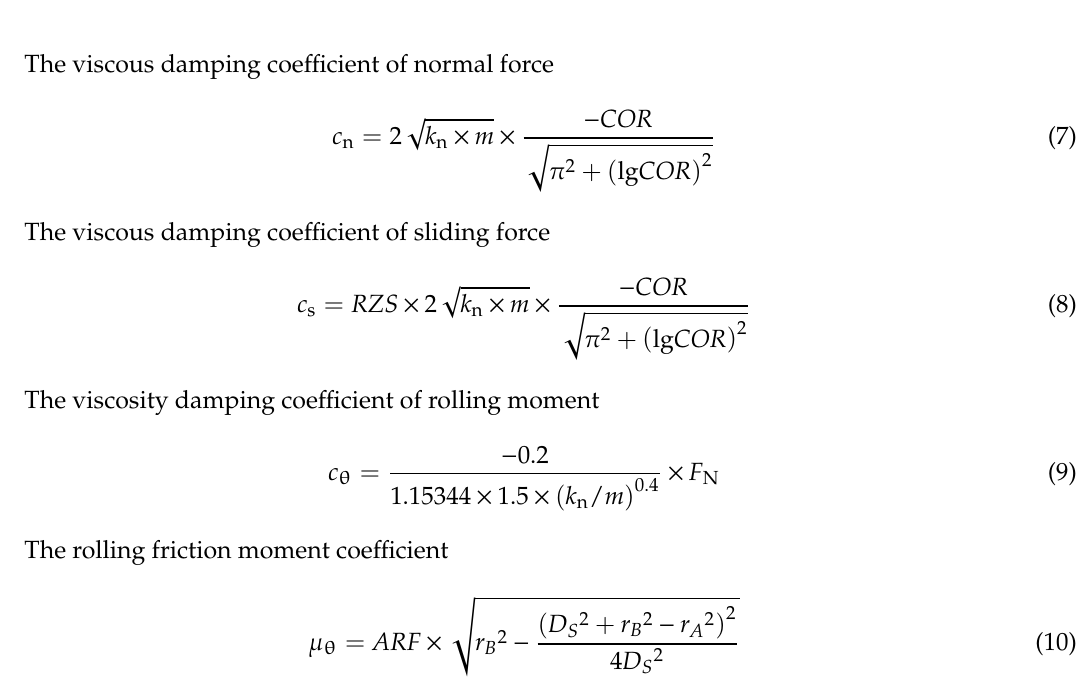
Figure 10. Axial stress-strain curve in triaxial test with 150 kPa confining pressure. Numerical verification was performed using a triaxial discrete element model with a test size of 1:1. Because the discrete element program is not easy to establish a cylindrical model, the discrete element model is approximated when the discrete element model is established. The size of the established three-axis discrete element model is 35 mm × 35 mm × 80 mm to ensure the cross-sectional area is consistent with the height, as shown in Figure 11. The particle diameter is 2 mm and the irregular arrangement is adopted. The number of particles is 11,636. The parameters used in the numerical simulation are shown in Table 3 to Table 6. Table 6. Parameters of 2 mm glass beads. Parameters